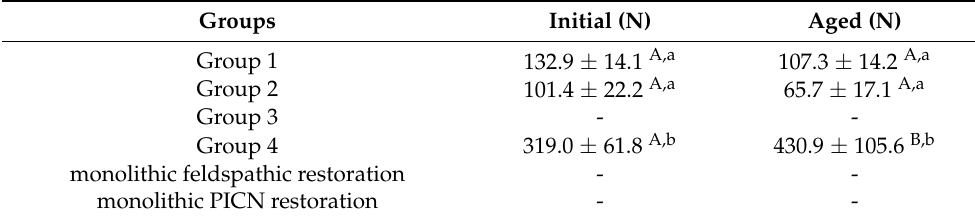
Table 2. Retention force means and standard deviations. Statistically significant differences between groups determined with Fisher-LSD post-hoc test are indicated with varying superscript letters ( p > 0.05) (upper case horizontal, lower case